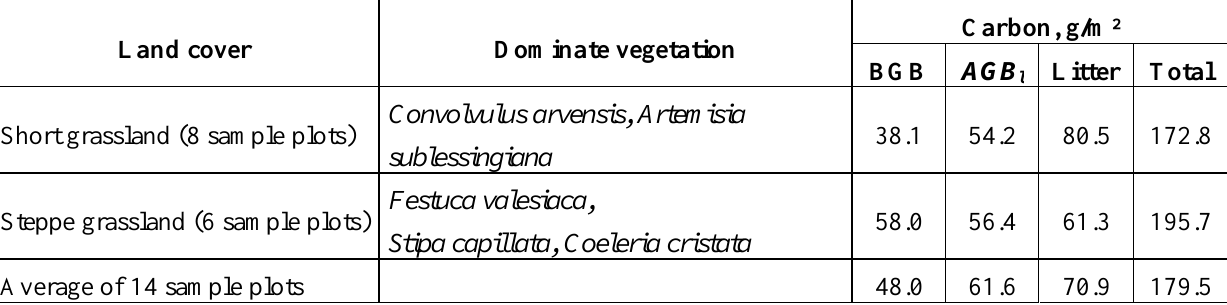
Table 1. Description of field data used for the modelling (averaged by land cover type). Land